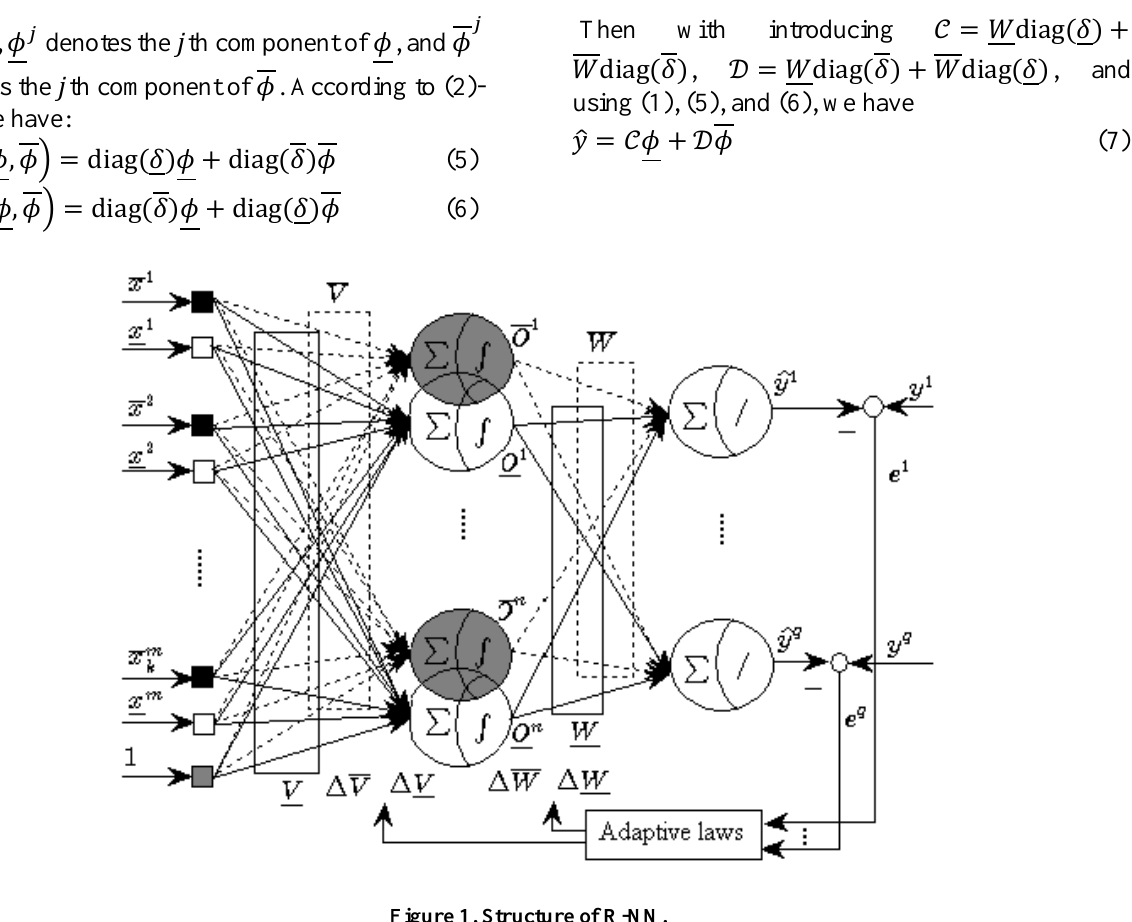
Figure 1. Structure of